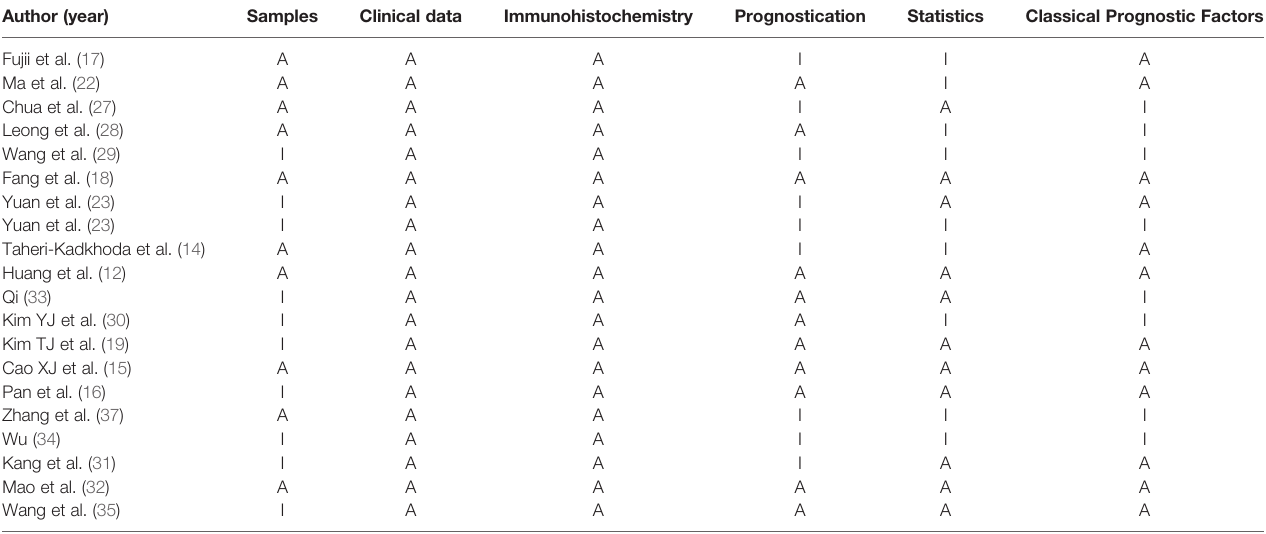
TABLE 2 | Included studies were evaluated according to the REMARK